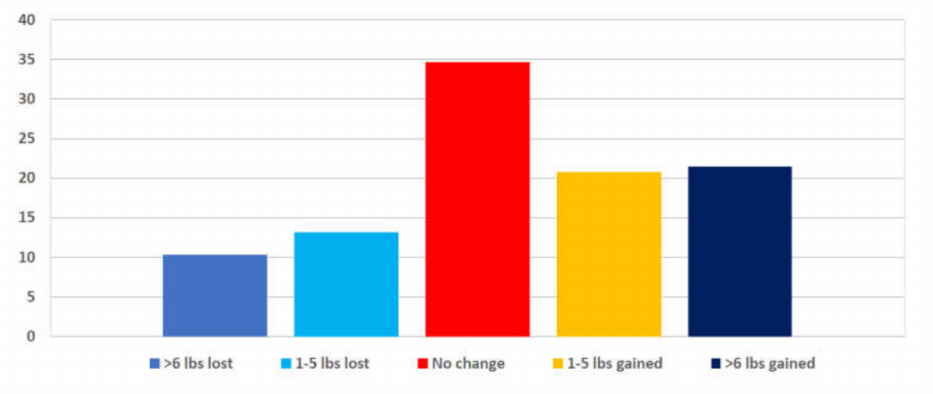
Figure 2. Percent of RDNs who self-reported weight change during the height of the COVID-19 pandemic. ( n = 450; individuals who reported pregnancy were excluded from